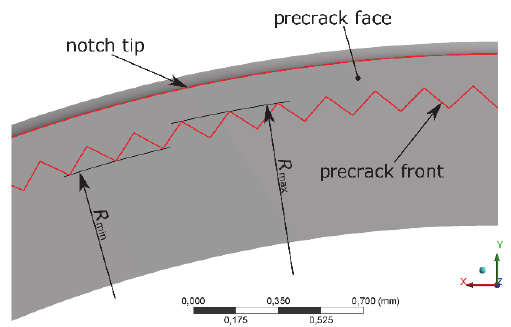
Figure 1: Scheme of the precrack emanating from the notch and possessing a serrated front.